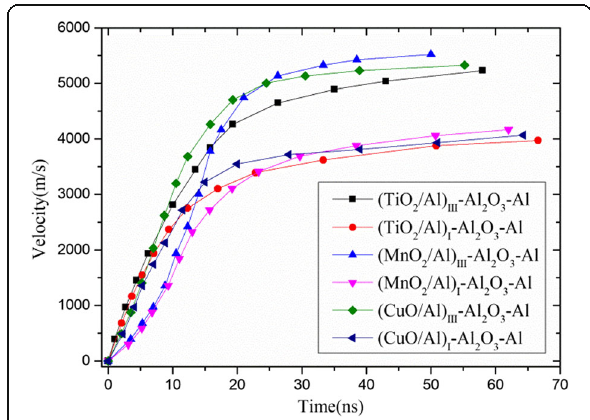
Fig. 6 Velocity-time curves reconstructed from PDV signal induced at 32.20 J/cm